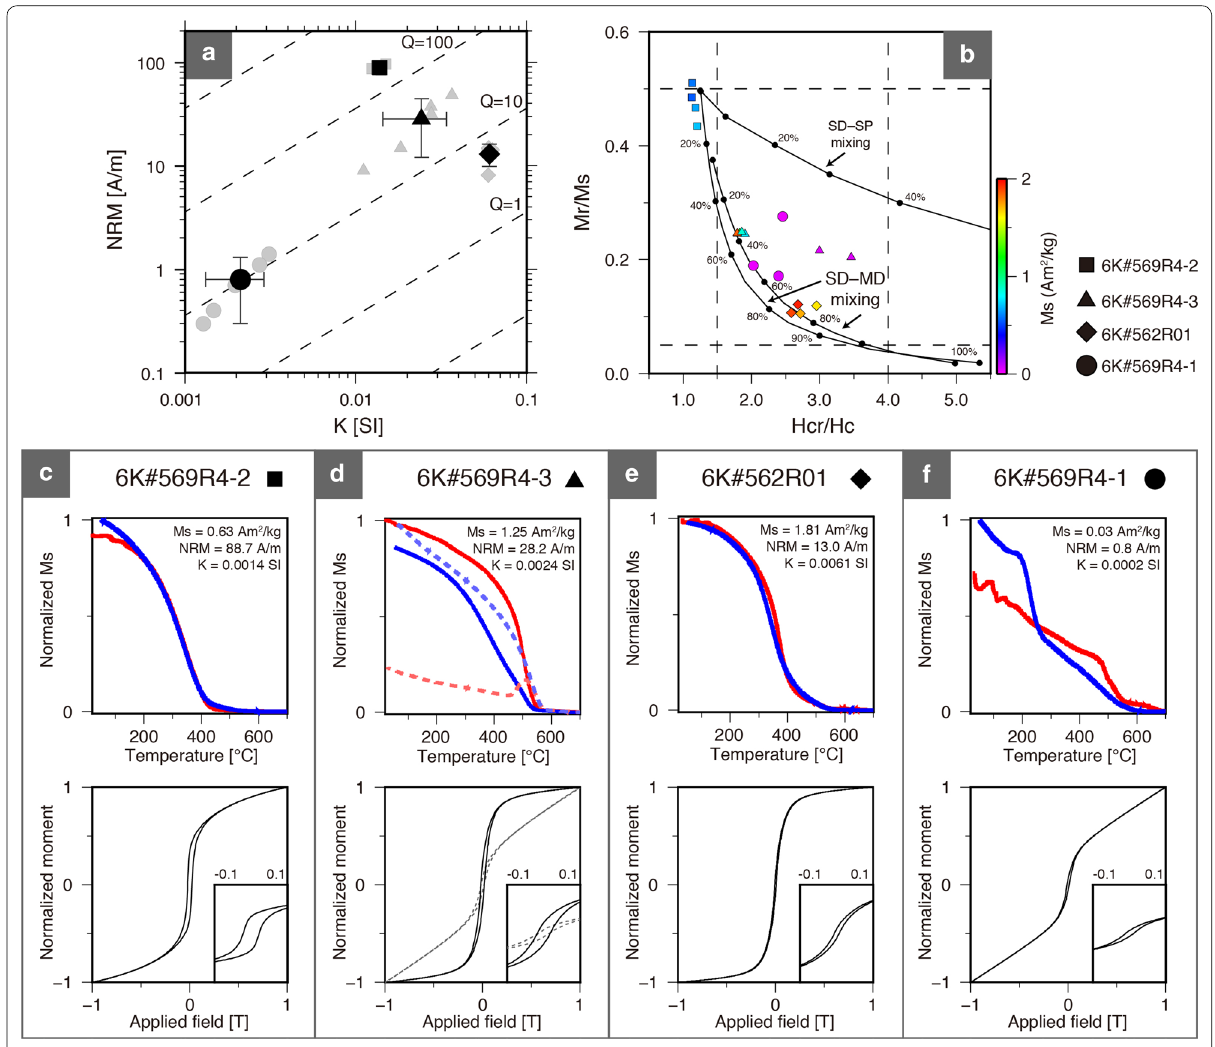
Fig. 5 Rock magnetic properties of the studied samples from the Irabu knolls of the Okinawa Trough; 6K#569R4‑2, 6K#569R4‑3, 6K#562R1, and 6K#569R4‑1; a magnetic susceptibility (K) and natural remanent magnetization (NRM). b Day plot showing hysteresis properties. c , d , e , and f thermomagnetic curves from 100 to 700 °C (top) and magnetic hysteresis curves (bottom) of the studied samples; 6K#569R4‑2, 6K#569R4‑3, 6K#562R1, and 6K#569R4‑1, respectively. The 6K#569R4‑3 sample displays both fresh (solid line) and altered (broken line)